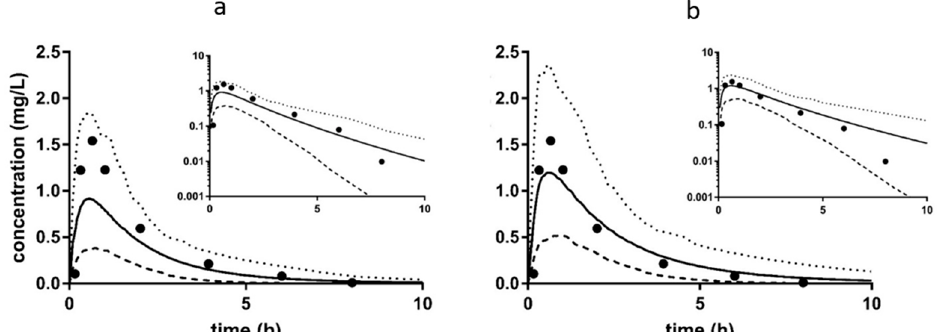
Figure 7. Comparison of Predicted Plasma Profiles for Zidovudine in Renally Impaired Patients for Base and Modified Simulations. Simulations were performed with oral administration of 200 mg of sildenafil to subjects (proportion of females 0.428) in a fasted state, age 56–62, the duration of the simulation was 48 h. These conditions are consistent with the parameters of the clinical study from which the observed data was obtained [27]. Simulations were performed with ten trials with ten subjects in each trial. Graphs represent that data on a linear scale, with the inset graphs representing the same data on a log scale. Closed circles are observed data, solid lines are the mean of the simulation, the dotted line is the 95 th percentile, and the dashed lines are the 5 th percentile. ( a ) Base Simulation—Sim GFR less than 30—simulation performed with the base moderate RI population and base zidovudine compound file; ( b ) Modified Simulation— f u +25% UGT2B7 R1—simulation performed with a 25% increase in f u for zidovudine, and competitive inhibition of UGT2B7 with an R ([I]/ K i ) value of 1.